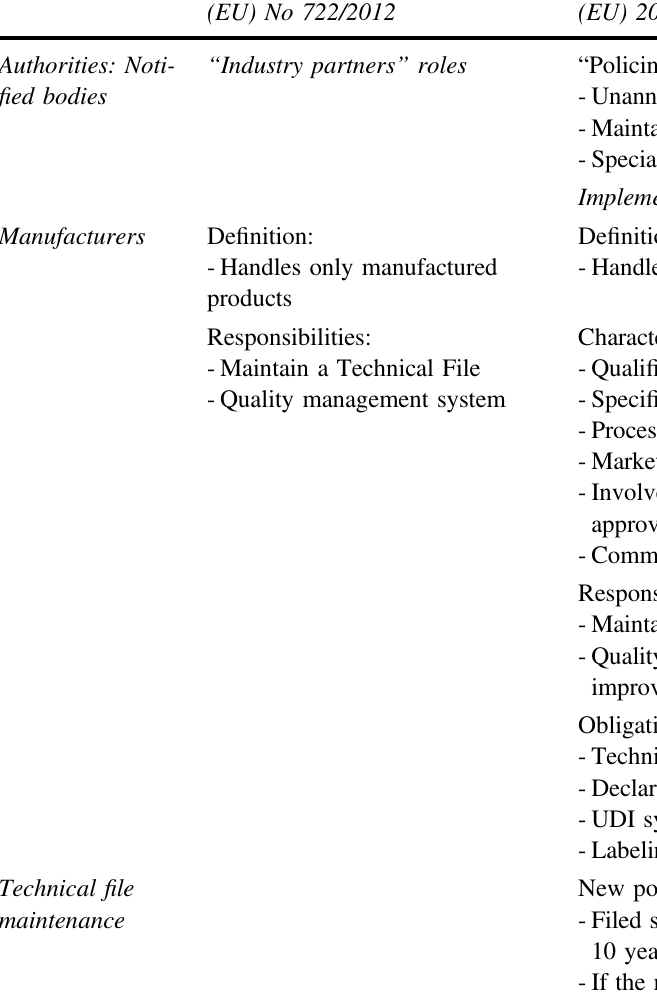
Table of main differences between the former and the new law